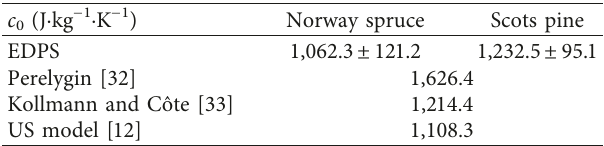
Table 4: Comparison of experimentally determined specific heat capacity and the specific heat capacity calculated using the models at the moisture content of 0%.